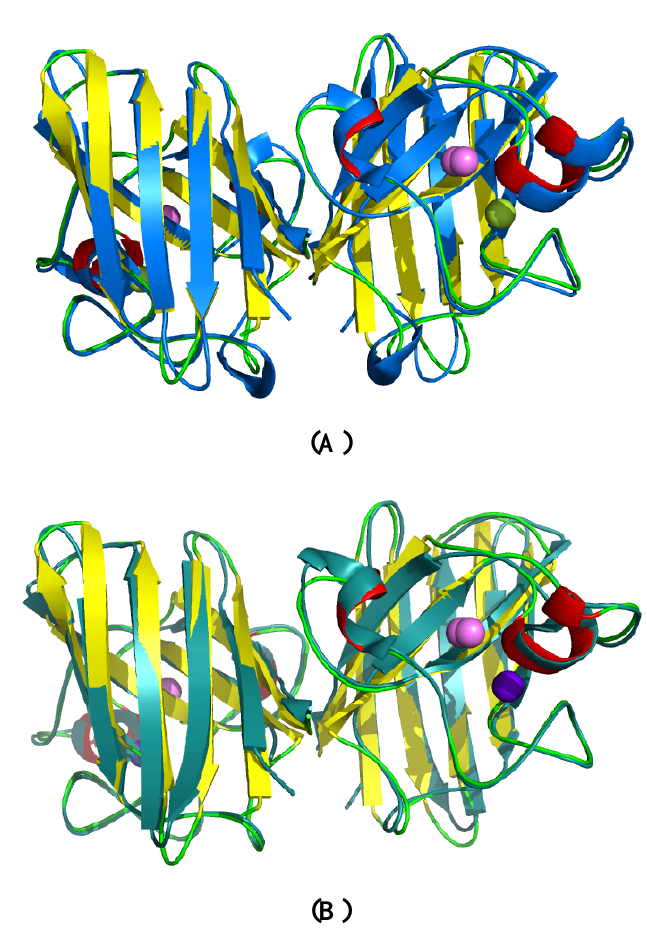
Figure 7. Superimposed 3D structure of cSOD1 Camelus dromedarius (yellow) with Homo sapiens (blue) ( A ) and Bos taurus (deepteal) ( B ). Copper and zinc are shown in purple and green colors, respectively. The superimposition indicated very high similarity